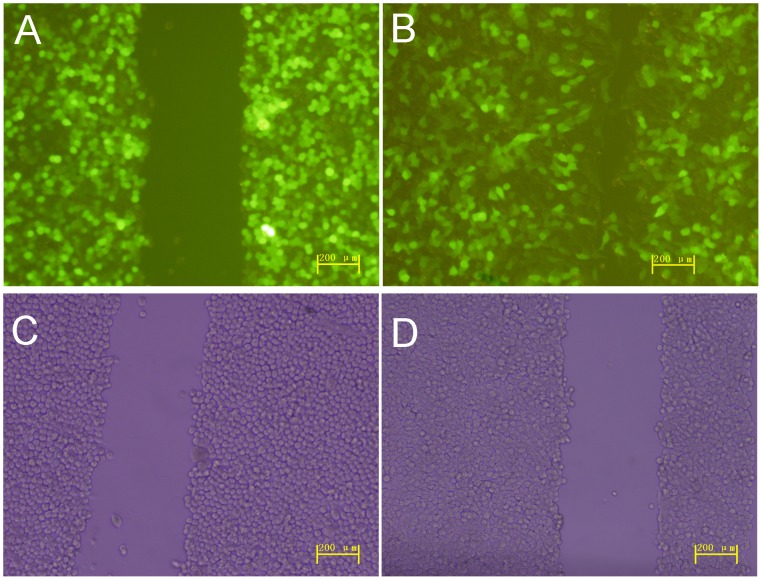
Effect of Ad-hITF on cell migration.HT-29 cells were infected with recombinant Ad-hITF adenovirus (A) or empty Ad-EGFP virus (C). Wounds were established in confluent monolayers of HT-29 cells and the wounded monolayers infected by recombinant Ad-hITF adenovirus (B) or empty Ad-EGFP virus (D) were cultured for 24 h in serum-free Dulbecco’s modified Eagle medium.